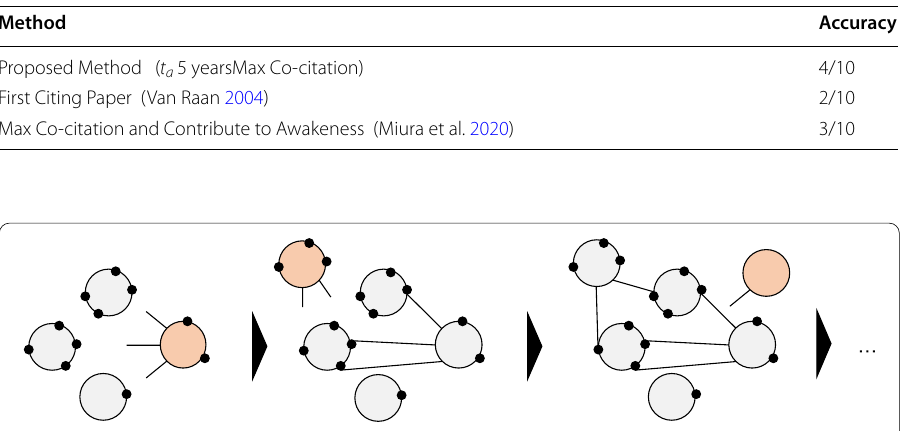
Fig. 11 Illustration of the null model. Each node (paper) has a potential of k o (the number of black dot), which is defined by its 2020 citation, and every after adding new nodes every year, new edges are created with equal probability based on the remaining black